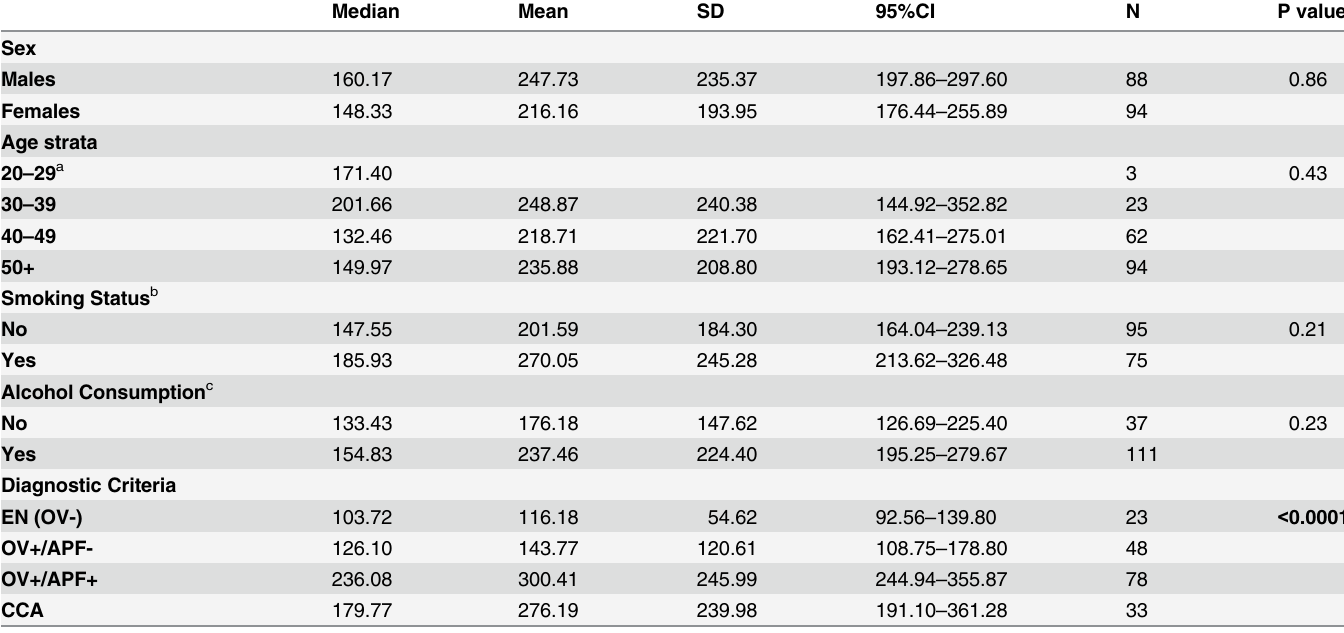
Table 1. Creatinine adjusted levels of urine 8-oxodG in the study